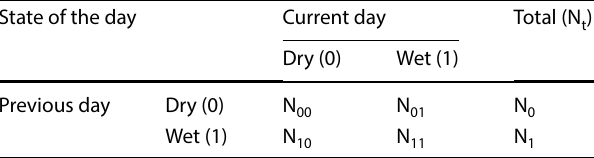
Table 3 Estimation of transition probabilities of observed rainfall State of the